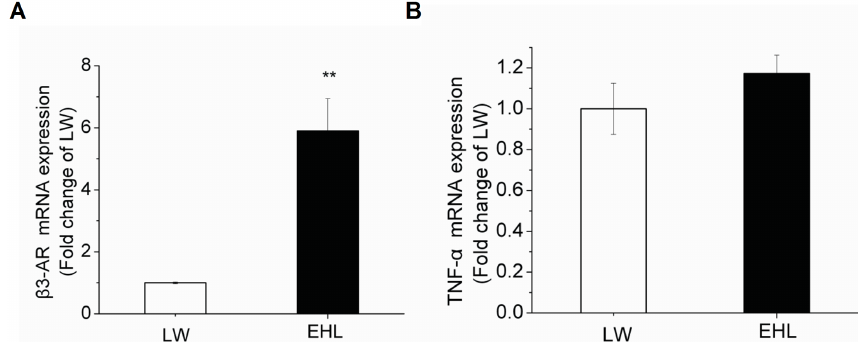
Figure 5. mRNA expression of TNF α and β 3-AR in subcutaneous fat of LW and EHL pigs. (a) TNF α mRNA expression and (b) β 3-AR mRNA expression. The values shown represent the mean ± standard error, n = 6; ** P <0.01 vs.